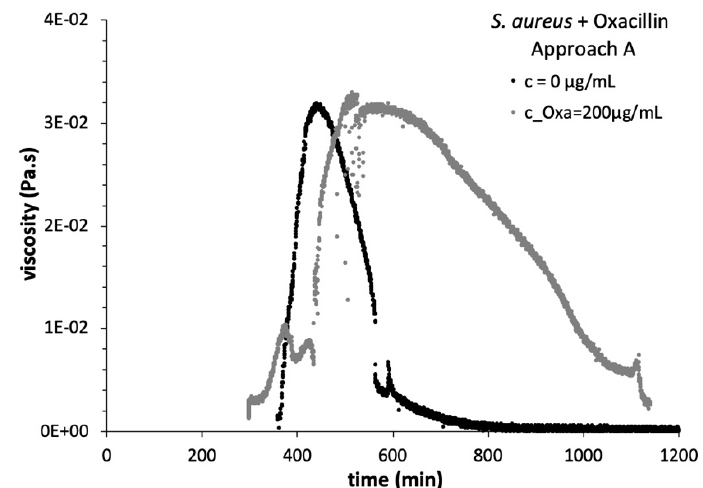
Figure 4. Viscosity growth curves for bacterial cultures of S. aureus , with and without the addition of antibiotic in the incubator at t = 300 min, approach A, followed by rheologic measurement: with no addition of antibiotic c = 0 µg/mL (full black symbol) and with oxacillin in concentration c_Oxa = 200 µg/mL (full gray symbol); all measurements were performed at a constant shear rate of 10 s −1 (representative curves) and at 37 °C.